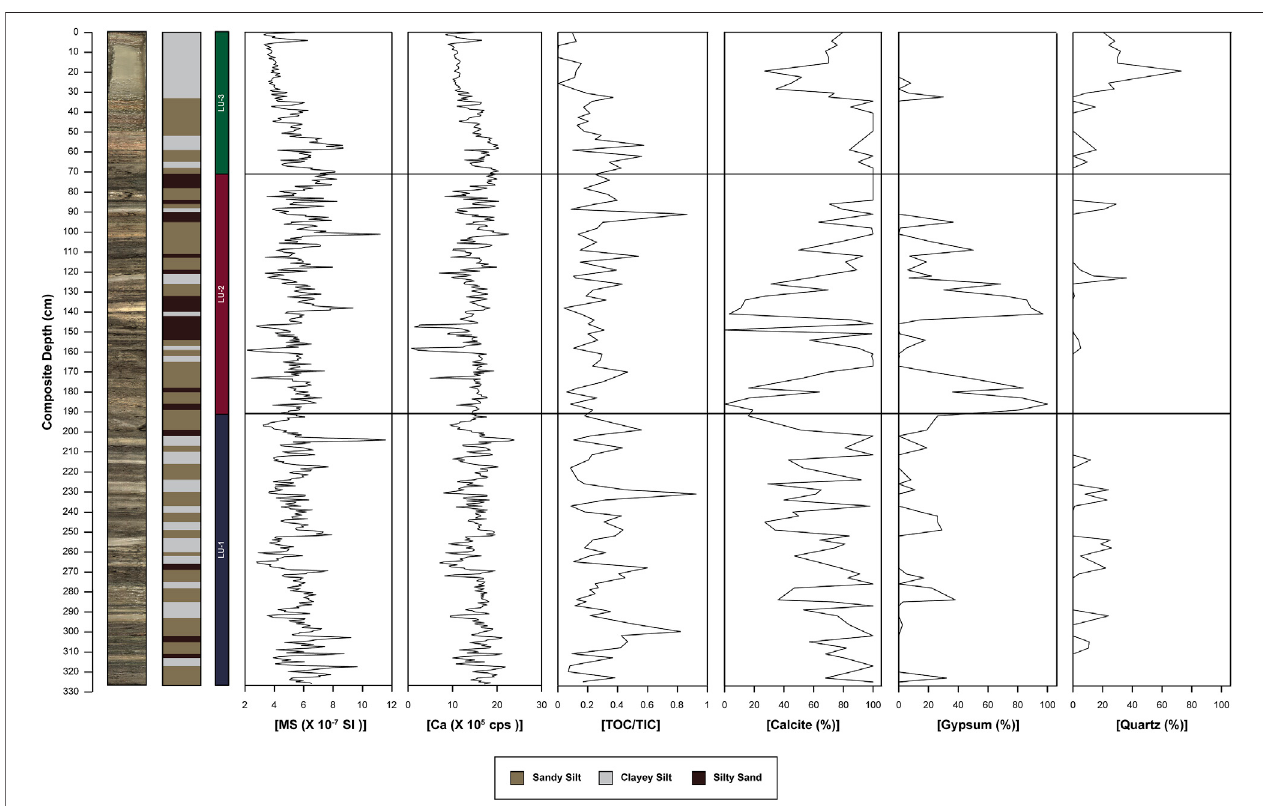
FIGURE3| Thelithology ofGayal elBazal sedimentcoreshowingthemagneticsusceptibility(MS), theXRF(Cacounts),theXRDdata(calcite, gypsumand quartz abundance), and TOC/TIC values.